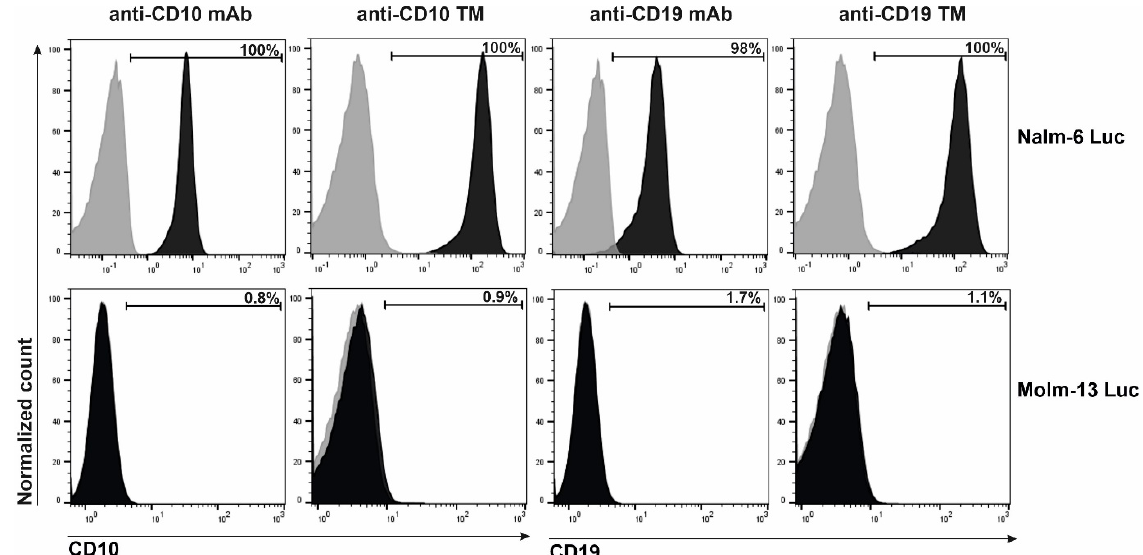
Figure 2. Binding of the novel anti ‐ CD10 TM to Nalm ‐ 6 cells. Nalm ‐ 6 Luc or Molm ‐ 13 Luc cells were stained with either VioBlue ‐ conjugated anti ‐ CD10 mAb, anti ‐ CD10 TM, VioBlue ‐ conjugated anti ‐ CD19 mAb or anti ‐ CD19 TM. The binding of the TMs was then detected using anti ‐ La mAb (clone 5B9) followed by anti ‐ mouse ‐ IgG ‐ Alexa Fluor 647. Binding is represented by a shift in the signal (dark gray). As a negative control, cells were stained with either VioBlue ‐ conjugated isotype control or with anti ‐ La mAb and the detection Ab without the TM (light gray). Binding is indicated as a percentage (%) of positively stained cells .